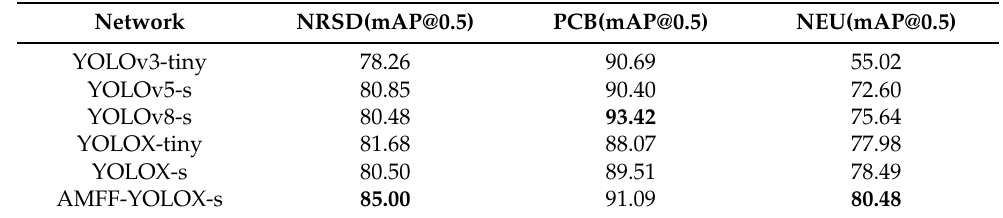
Table 3. Comparative experimental results (mAP@0.5) of detection in the industrial defect dataset. Network